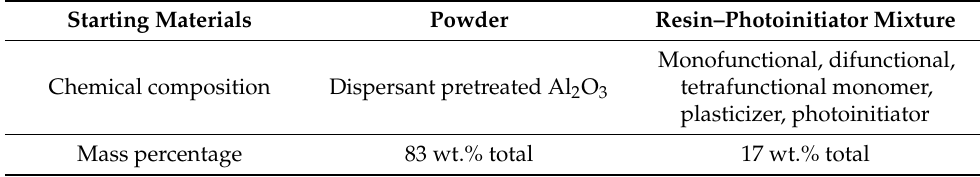
4 Figure 2. Sintered samples resulting from the different sintering trials. The diameter and height dimensions of the green, brown, and sintered samples were collected. Four samples were fabricated for each sintering trial, and the average values of diameters and heights, together with the correspondent standard deviations, were